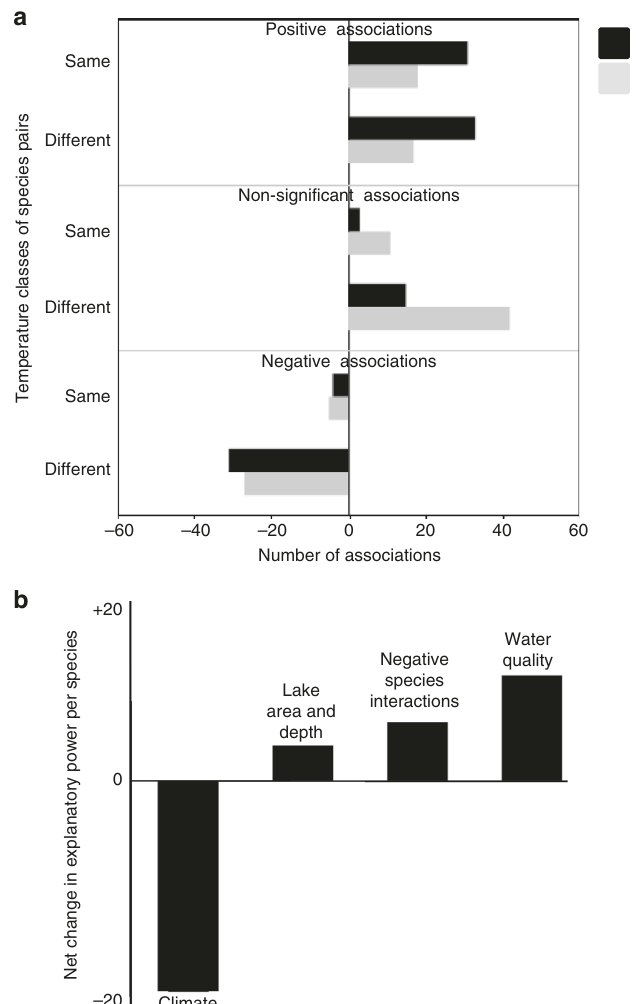
Fig. 3 Frequency of negative, positive, and non-associated pair-wise interactions between among-lake richness versus within-lake abundance. a Frequency of signi fi cantly positive, nonsigni fi cant, and negative associations among 231 species pairs of freshwater fi sh in 721 lakes, for two classes of data: lake presence/absence (differences in among-lake richness) and lake abundance based on catch per unit effort for each species in each lake (differences in within-lake abundance). We hypothesized an increase in the frequency of negative interactions within-lakes but this was generally not the case, for both species pairs in the ‘ same ’ temperature class (e.g., two species of ‘ warm-water ’ fi sh, Supplementary Table 1) versus ‘ different ’ classes (warm vs cold-water species). b Relative change in the importance of four major explanatory factors (climate, morphometry, water quality, and negative species interactions) between BRT analyses of among-lake richness to BRT analyses of within-lake abundance (see Supplementary Table 3). Signi fi cant thresholds were based on an α <